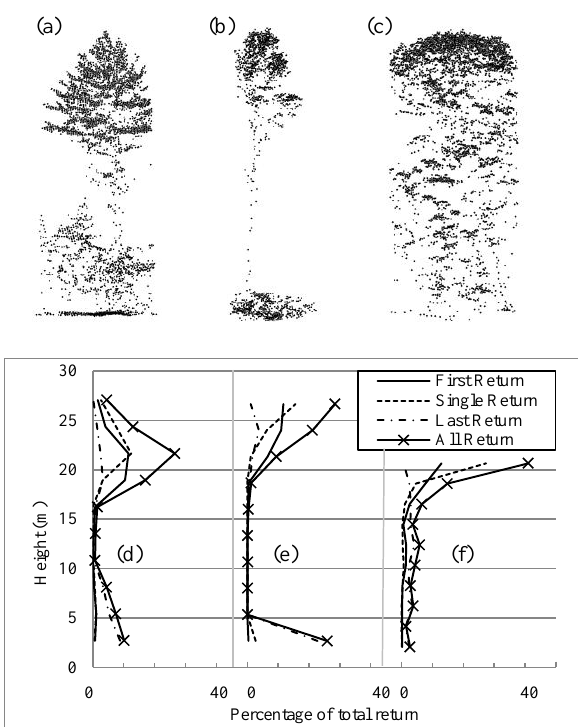
Table 1. Descriptive summary of geometric derived features